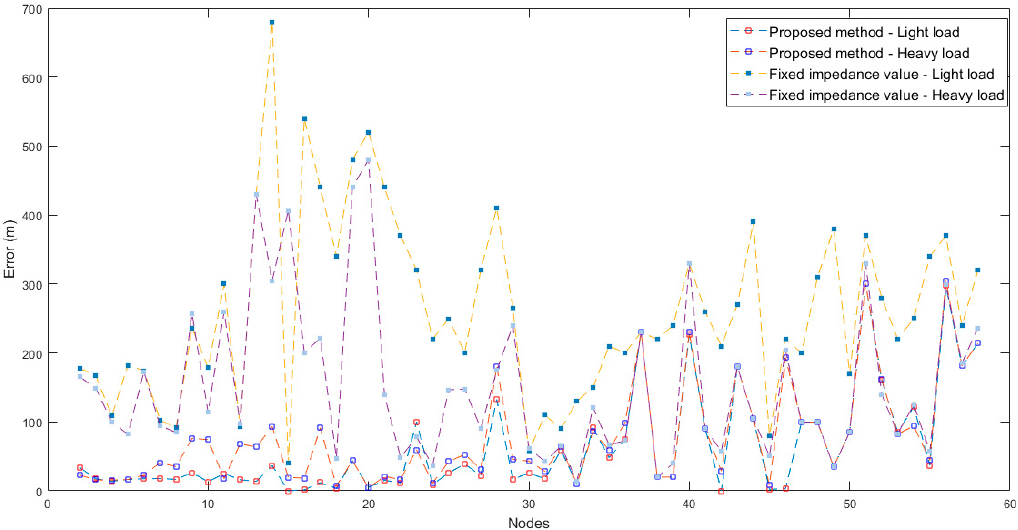
Figure 11. Fault location error for different types of faults.